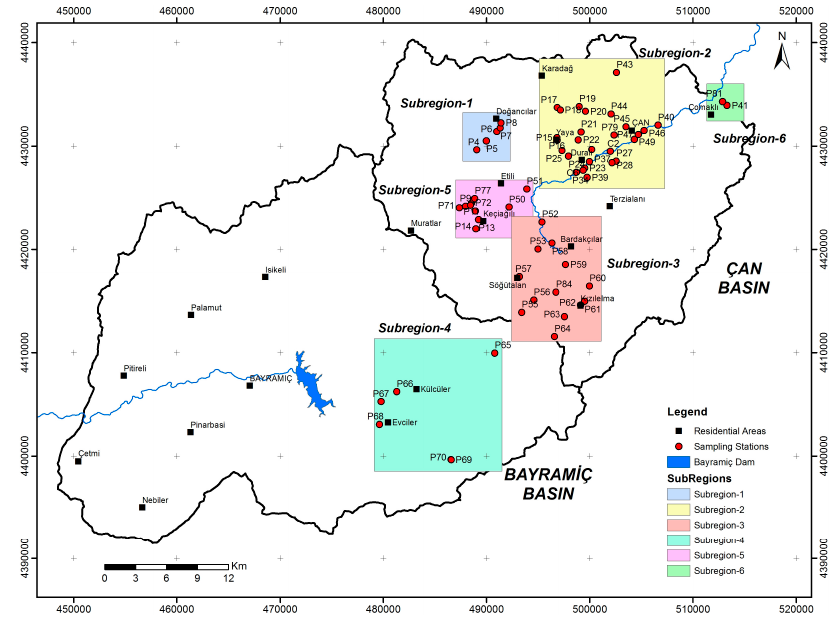
Figure 3. Sample location map.